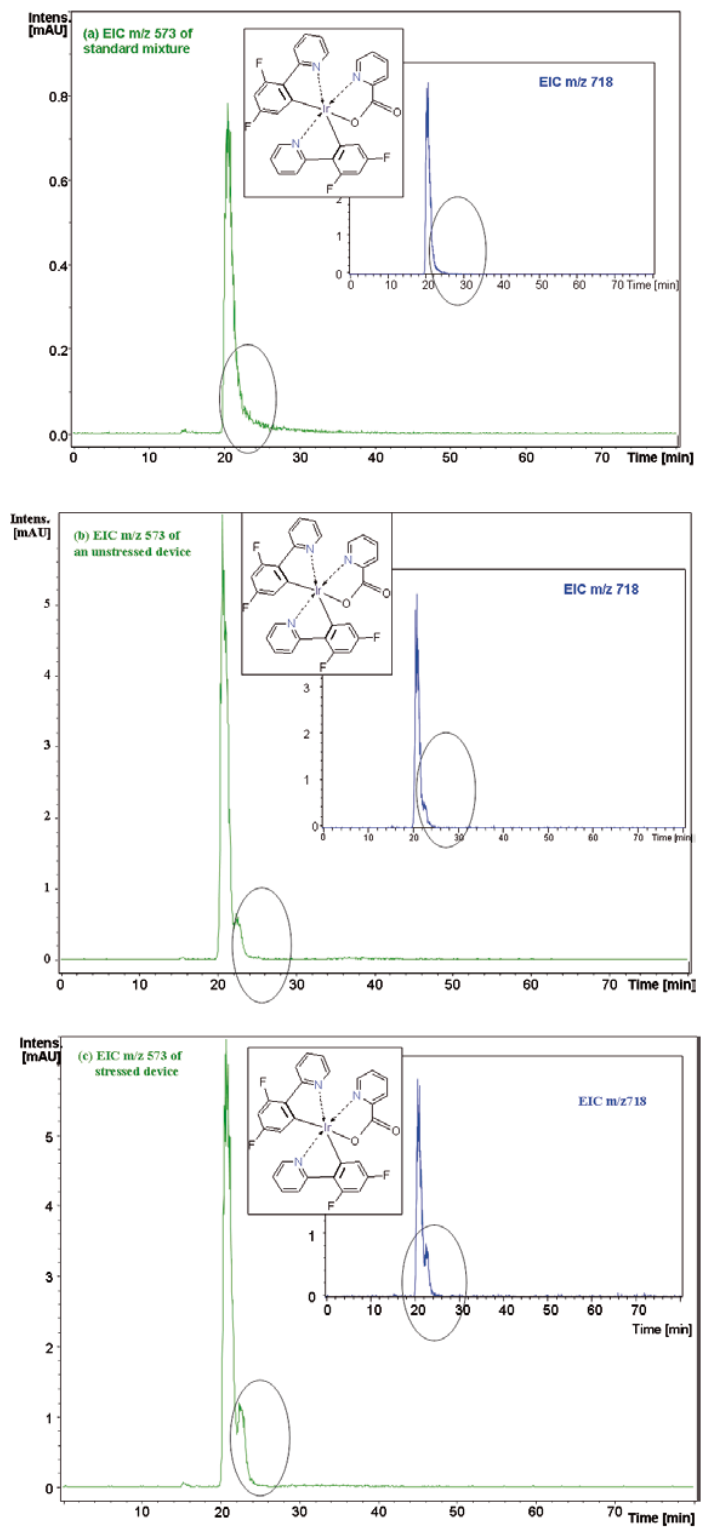
Figure 3. EIC chromatograms of (a) pure materials α -NPD, TCTA, FIrpic and BAlq; (b) unstressed device and (c) stressed